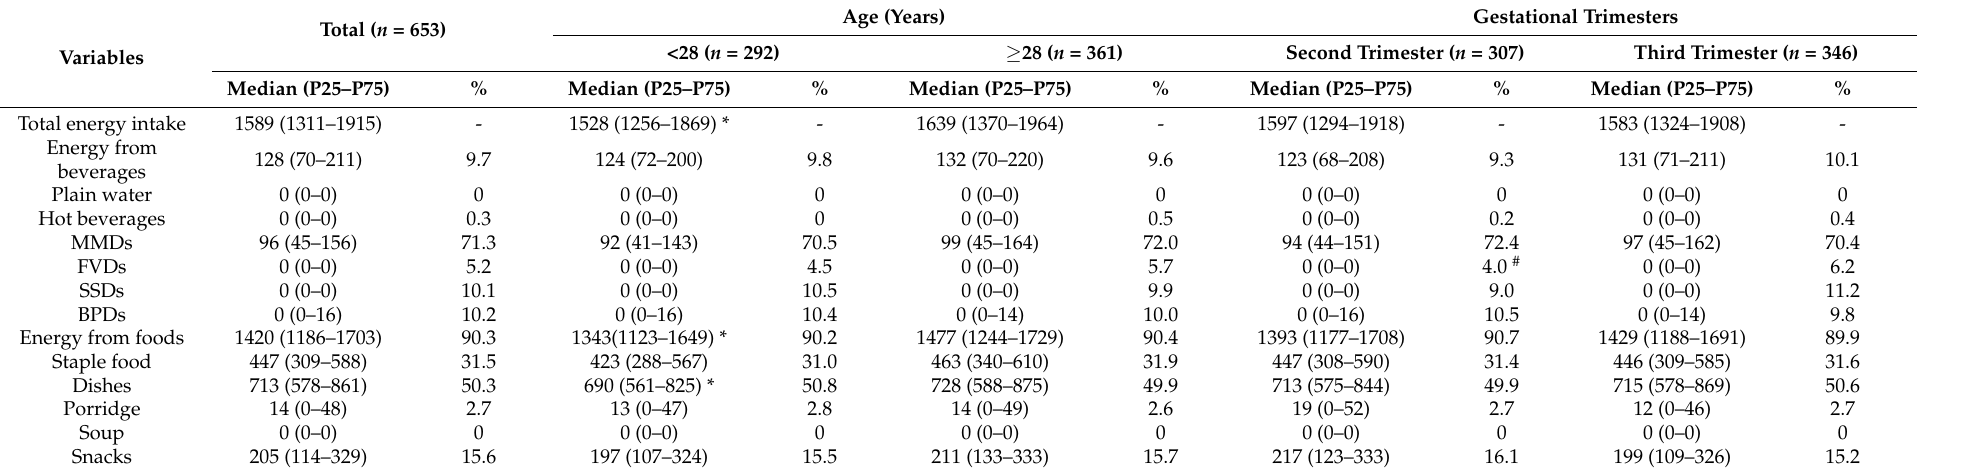
Table 3. Median daily energy intake (kcal/day) and contribution of energy intake from different sources (%) among Chinese pregnant women in 2018 categorized by age and gestational